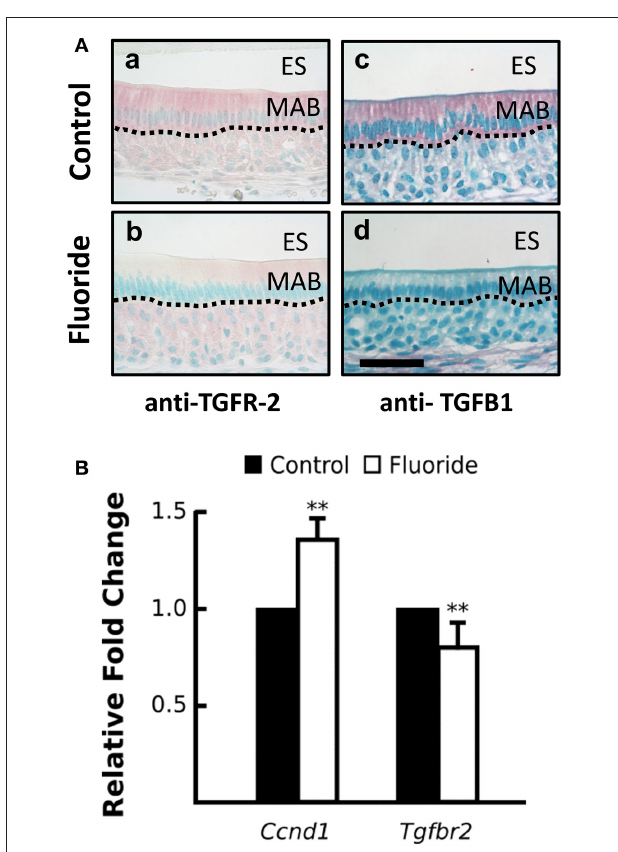
FIGURE 4 | Fluoride altered expression CCND1 and TGFR-2, regulators of androgen receptor activation. (A) Images of red TGFR-2 (a–c) and TGF β 1 (b–d) immunostaining show fluoride-exposed maturation ameloblasts have decreased amounts of TGFR-2 (b) and TGF β 1 (d) protein compared to controls (a and c). Scale bar 50 um, ES; enamel space, MAB; maturation ameloblast (B) Relative fold change of Ccnd1 was increased, whereas Tgfbr2 expression was decreased in maturation-stage ameloblasts harvested from fluorosed as compared to control mice. Genes were normalized to the expression of Mrpl19 . ** p <